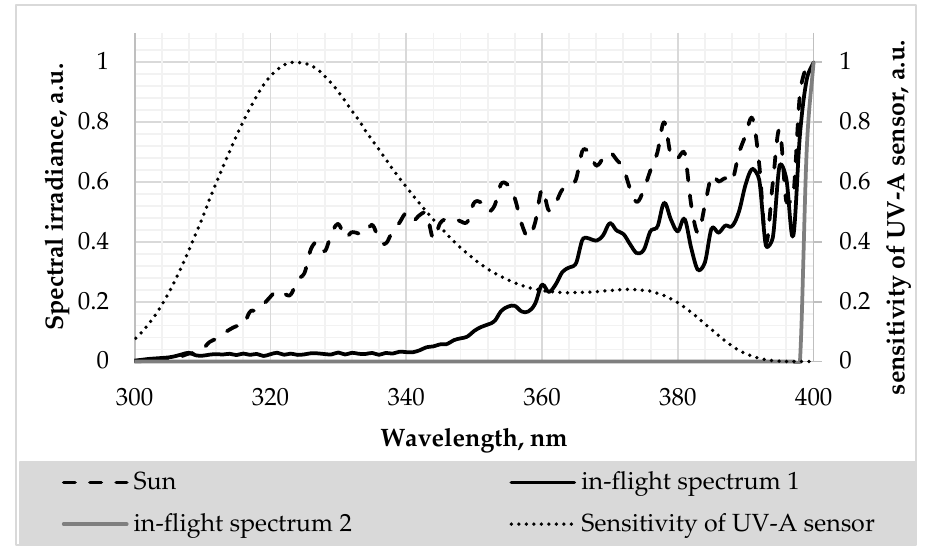
Figure 2. Examples of relative solar spectra measured inside cockpits [8] and spectral sensitivity of the UV-A detector (dotted line) shown as relative values (arbitrary units, a.u.).